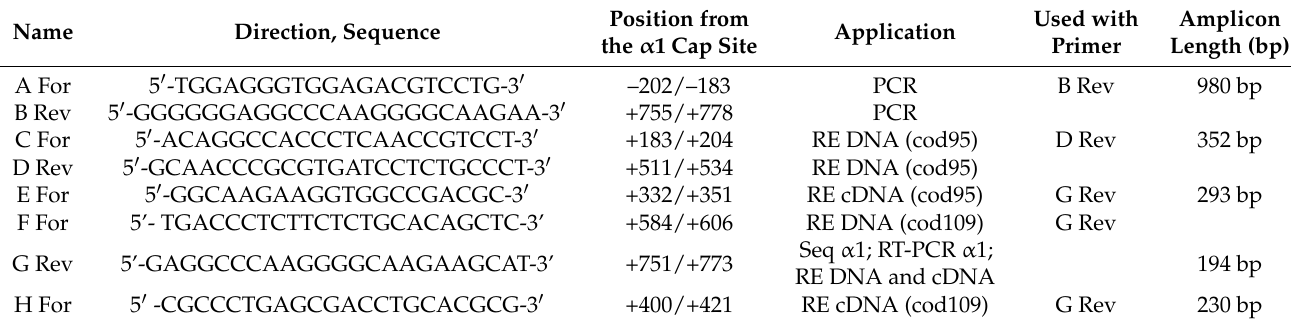
Table 1. Oligonucleotides used as primers in the reported applications. The sequences and positions of the primers were derived from GeneBank Sequence